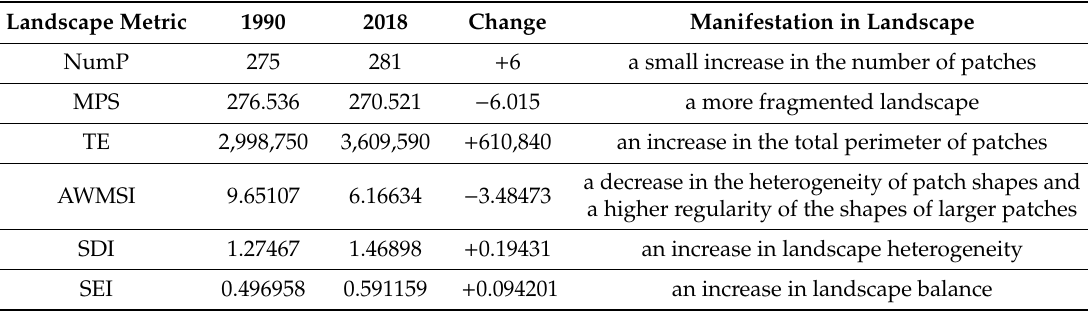
Table 5. Landscape metrics changes between 1990 and 2018 at the landscape level. Landscape Metric 1990 2018 Change Manifestation in Landscape NumP 275 281 + 6 a small increase in the number of patches MPS 276.536 270.521 − 6.015 a more fragmented landscape TE 2,998,750 3,609,590 + 610,840 an increase in the total perimeter of patches a decrease in the heterogeneity of patch shapes and AWMSI 9.65107 6.16634 − 3.48473 a higher regularity of the shapes of larger patches SDI 1.27467 1.46898 + 0.19431 an increase in landscape heterogeneity SEI 0.496958 0.591159 +